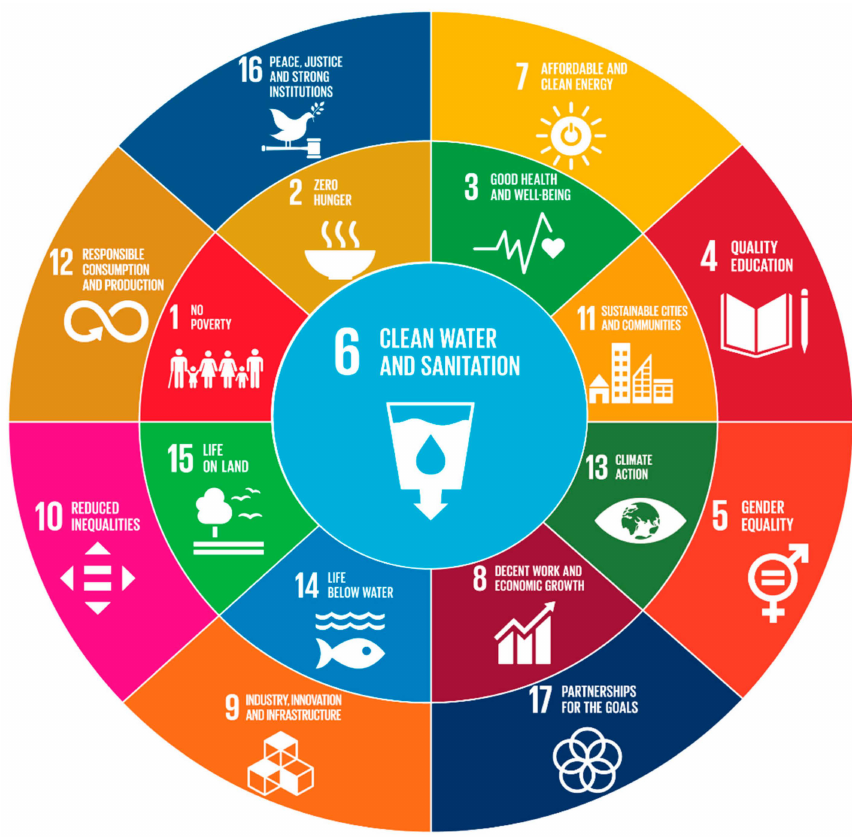
Figure 1. The water-centric 17 Sustainable Development Goals